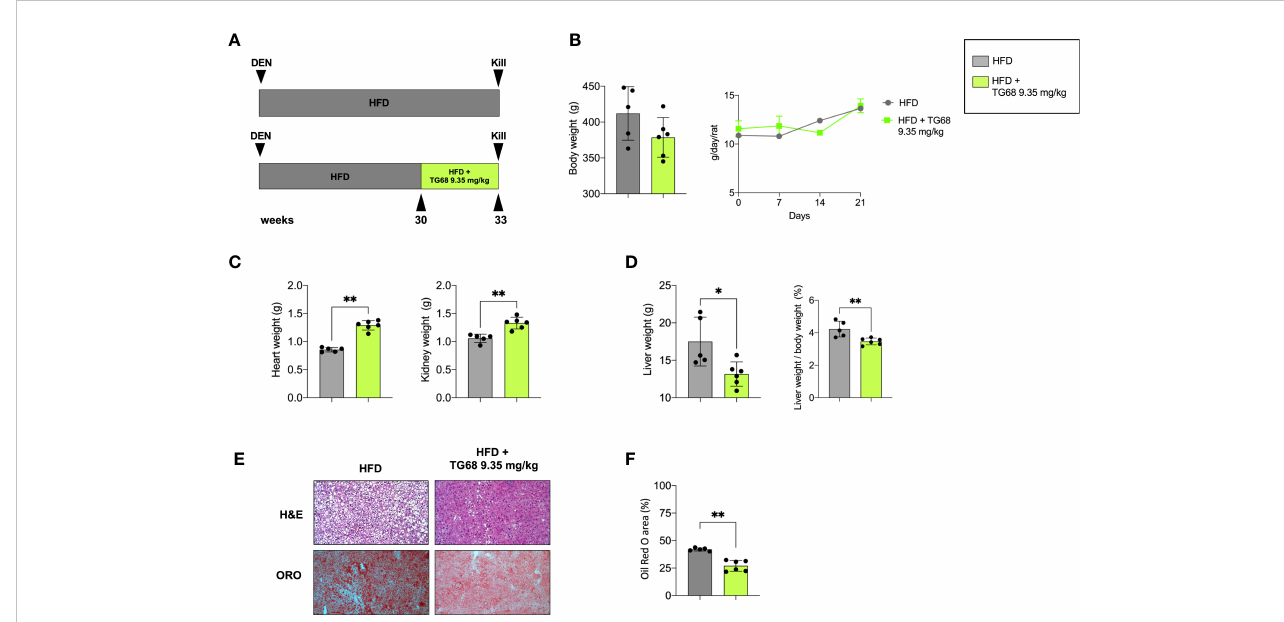
FIGURE 1 Effect of a three-week treatment with TG68 on kidney, heart and liver weight and hepatic steatosis. (A) Experimental design and timeline of the in vivo experiments; (B) Body weight and Daily food consumption throughout the whole experiment; (C) Heart weight and Kidney weight; (D) Liver weight and Liver weight/body weight ratio; (E) Representative images of liver sections stained with hematoxylin and eosin (H&E, 10x) or Oil Red O (ORO, 10x) at 9.35 mg/kg of TG68; (F) ORO staining positive area quanti fi cation by using ImageJ. Data were normalized to HFD alone. Groups were compared by student ’ s t-test. Values are shown as mean ± standard deviation of 5 to 6 rats/per group. * p <0.05, **p<0.01 HFD, High Fat Diet; DEN, Diethylnitrosamine; H&E, hematoxylin and eosin; ORO, Oil Red